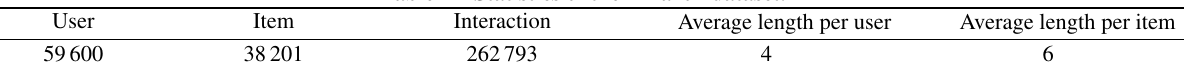
Table 2 Statistics of the Amazon